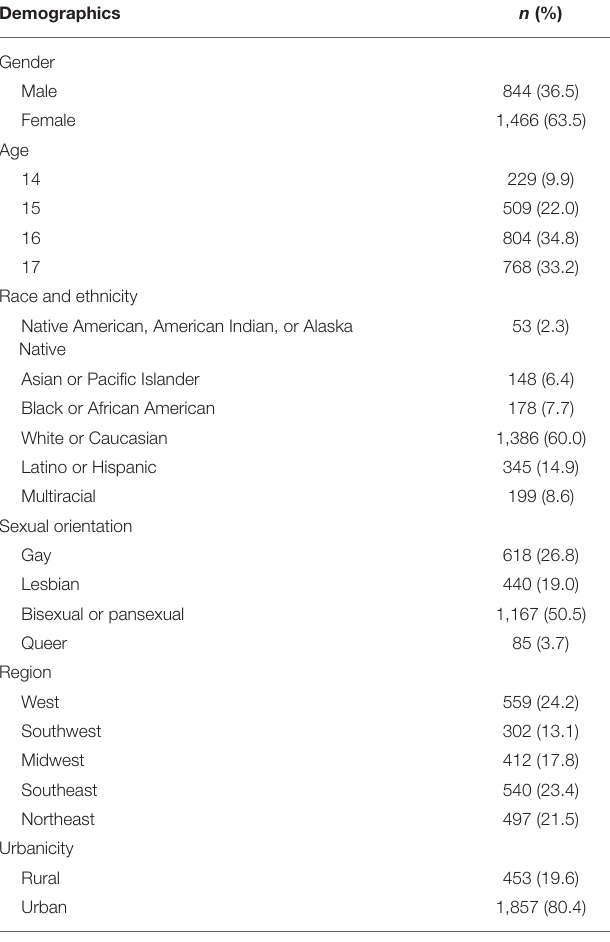
TABLE 1 | Demographics of participating youth ( N =